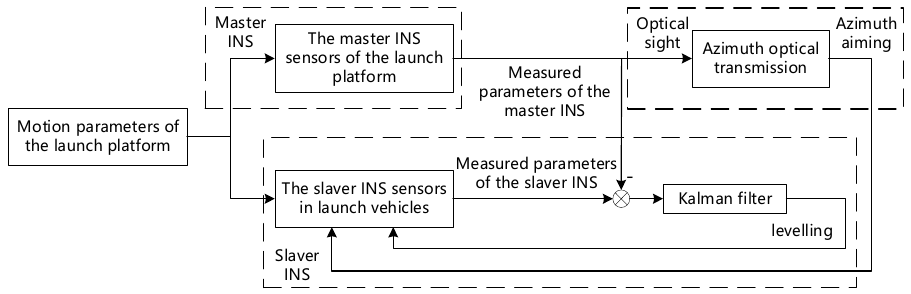
Figure 1. Fundamentals of initial alignment of launch vehicles.